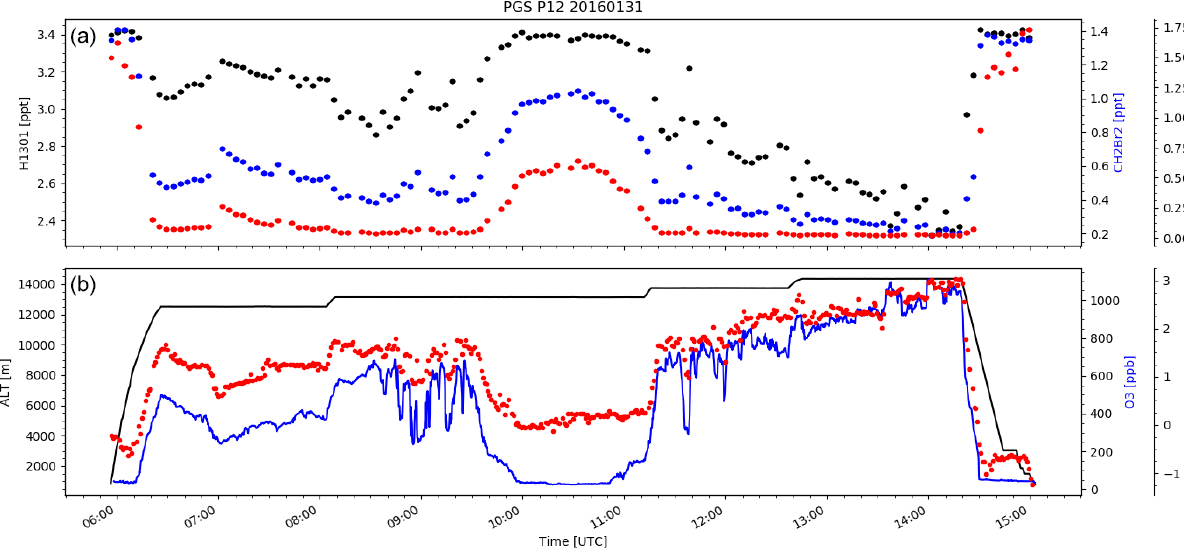
Figure 3. Example of data gathered during a single flight of HALO during the PGS campaign. The flight PGS 12 started on 31 January 2016 from Kiruna in northern Sweden. Panel (a) shows measurements of the long-lived brominated source gas halon 1301 (CF 3 Br) and the short- lived source gases CH 2 Br 2 and CHBr 3 , all measured with the GhOST-MS. Panel (b) shows flight altitude, ozone (parts per billion, ppb; 10 − 9 ; measured by the FAIRO instrument; Zahn et al., 2012) and mean age of air derived from SF 6 measurements from the ECD channel of the GhOST-MS (1min time resolution; see Bönisch et al., 2009, for a description of the measurement technique). An air mass with low ozone and also low mean age of air was observed during the middle of the flight between about 10:00 and 11:00UTC. High mixing ratios of all three source gases are found in this region, as well as during take-off and landing of the aircraft. CHBr 3 mixing ratios are close to detection limit when flying in aged stratospheric air masses, indicating a complete conversion of the bromine to its inorganic